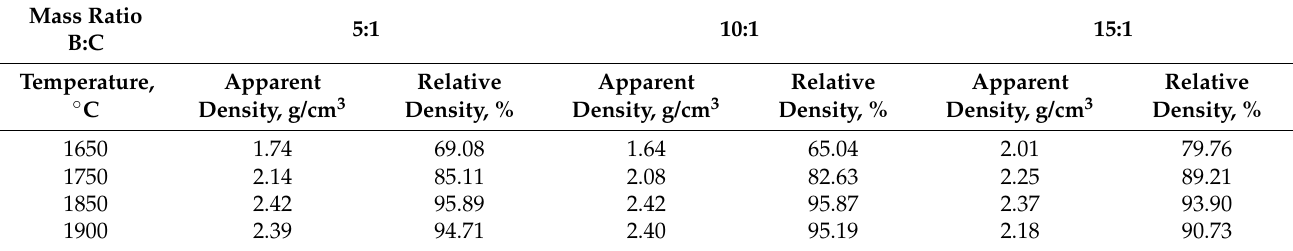
Figure 3. X-ray diffractograms of sintered polycrystals at different temperatures, made from mixtures with different B:C mass ratios; ( a ) 5:1 ( b ) 10:1 ( c ) 15:1 (the X-ray diffractograms show reflections coming from graphite and tetragonal B 48 (B 2 C 2 ). Other reflections are characteristic of rhombohedral boron carbides with different stoichiometry). Table 1. Results of measurements of apparent and relative densities of boron carbide sinters obtained by reaction sintering of mixtures with different B:C mass ratios using the pressure assisted sintering